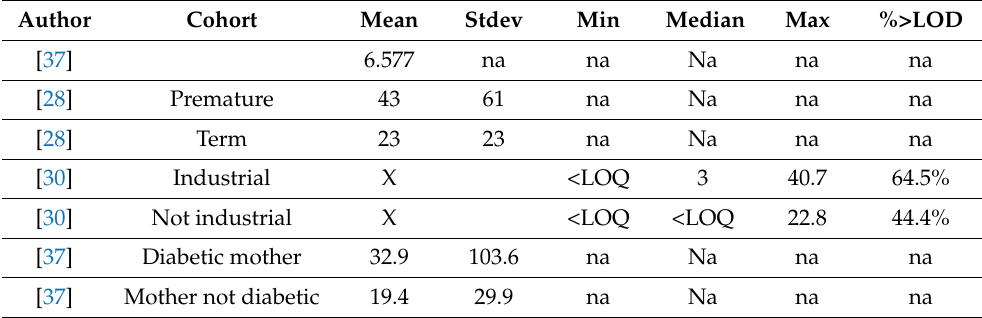
Table 6. Aluminum in meconium samples by cohort (“na” = not available in reference, “X” = not calculated by author, “LOQ” = lowest observable quantity, “LOD” =lowest